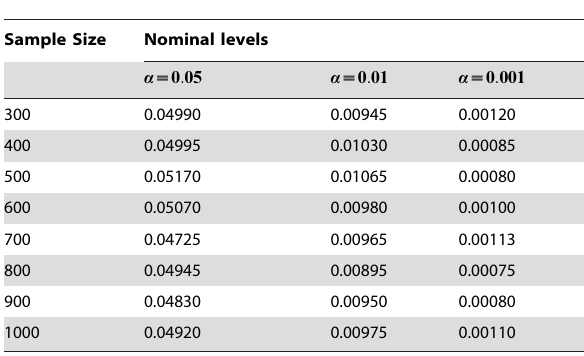
Table 2. Type I error rates of the statistic T IH to test for interaction between two loci, assuming OR G ~ OR H ~ 2 .